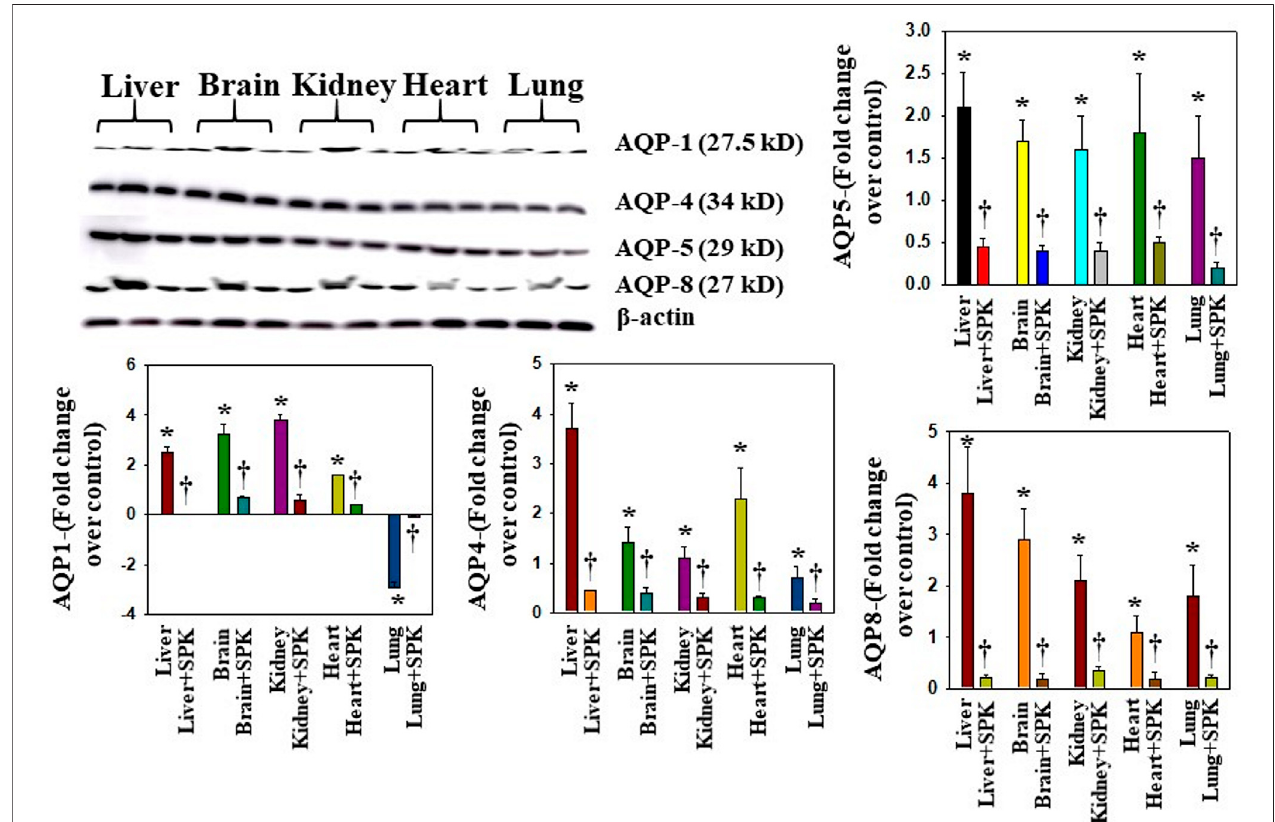
FIGURE7| AlteredAQPlevelswereidenti fi edinvariousorganspost-MHV-1inoculation.RepresentativeimmunoblotsshowedanincreaseinAQPs1,4,5,and8in various organs, while AQP1 levels were decreased in lungs post-MHV-1. Further, treatment of MHV-1 inoculated mice with SPK (5 mg/kg) reversed AQP levels. AQP levels are normalized against β -actin. ANOVA, n = 4. * p < 0.05 versus control; † p < 0.05 verses MHV-1 infected mice. Error bars represent mean ±